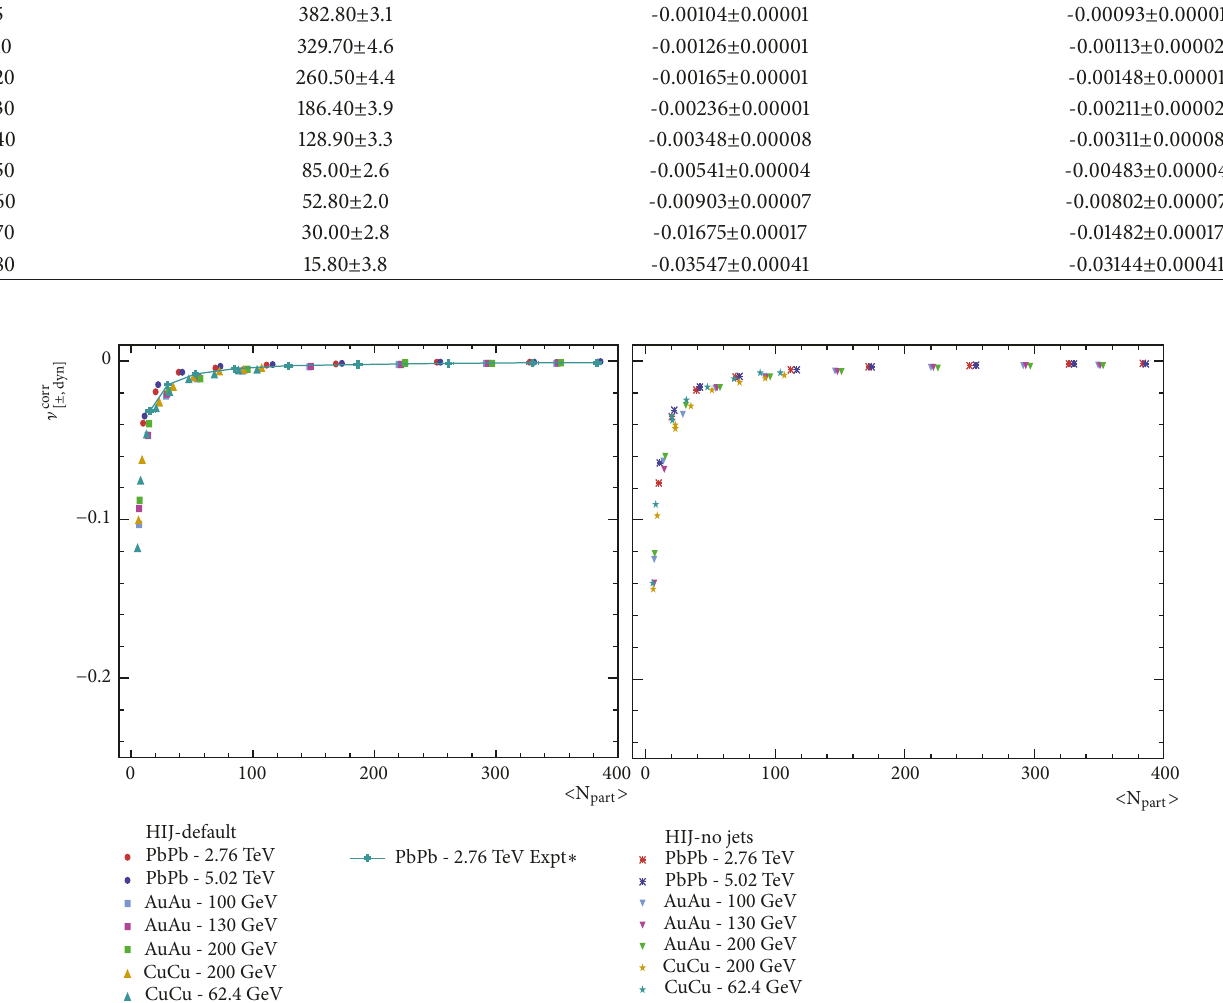
Table 5: Values of 𝑁 𝑝𝑎𝑟𝑡 , ] [+−,𝑑𝑦𝑛] , and ] 𝑐𝑜𝑟𝑟 [+−,𝑑𝑦𝑛] for 208 𝑃𝑏 − 208 𝑃𝑏 collisions at 2.76 TeV [data from [17]]. cent.%